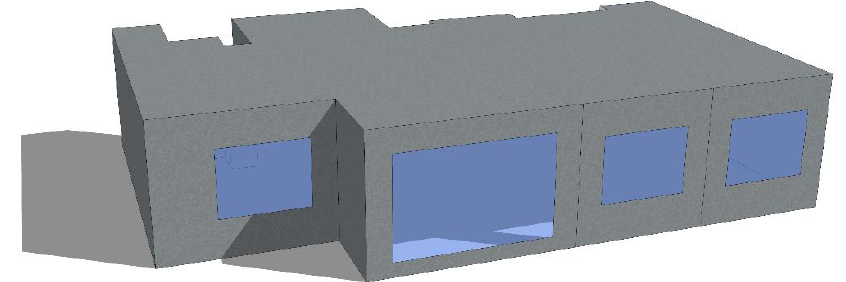
Figure 3. The energy model created by